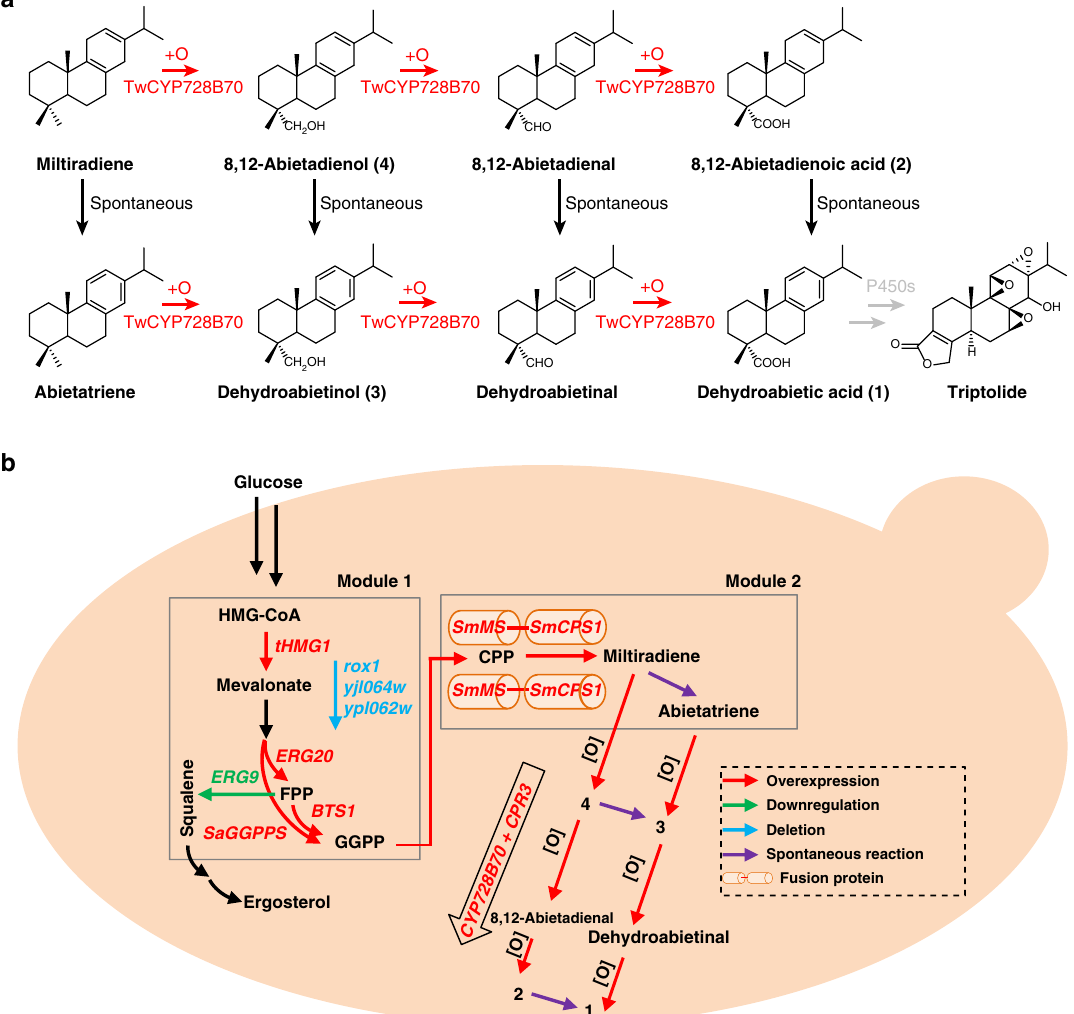
Fig. 4 Analysis of triptolide pathway and metabolic engineering. a Three reactions presumably catalyzed by CYP728B70 to convert miltiradiene to dehydroabietic acid. b Establishing the metabolic pathways in yeast for production of diterpene alcohols and acids. In module 1, rox1 , ypl062w , yjl06w4 were knocked out, and ERG9 was down-regulated, and tHMG1 , ERG20 , BTS1 , SaGGPPS were overexpressed to improve the production of GGPP. In module 2, double SmMS-SmCPS1 fusion modules were introduced into the yeast chromosome for the production of miltiradiene. Co-expression of TwCYP728B70 and TwCPR3 leads to the observed production of the derived alcohols and